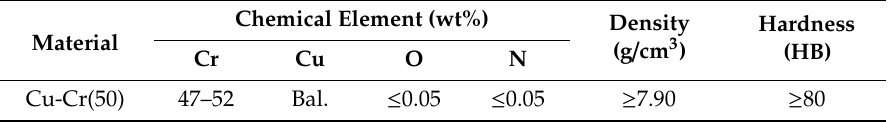
Table 1. Chemical composition and mechanical and physical properties of Cu-Cr alloy.